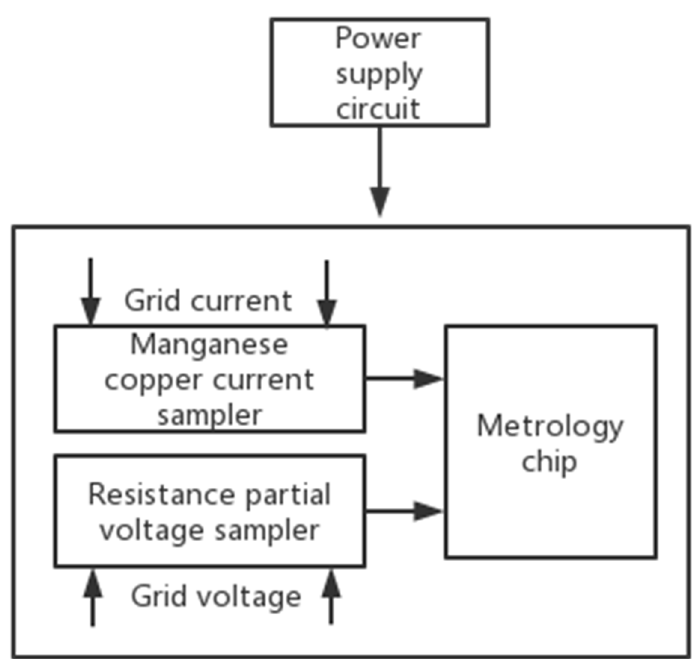
Figure 2. Schematic diagram of metrology module.